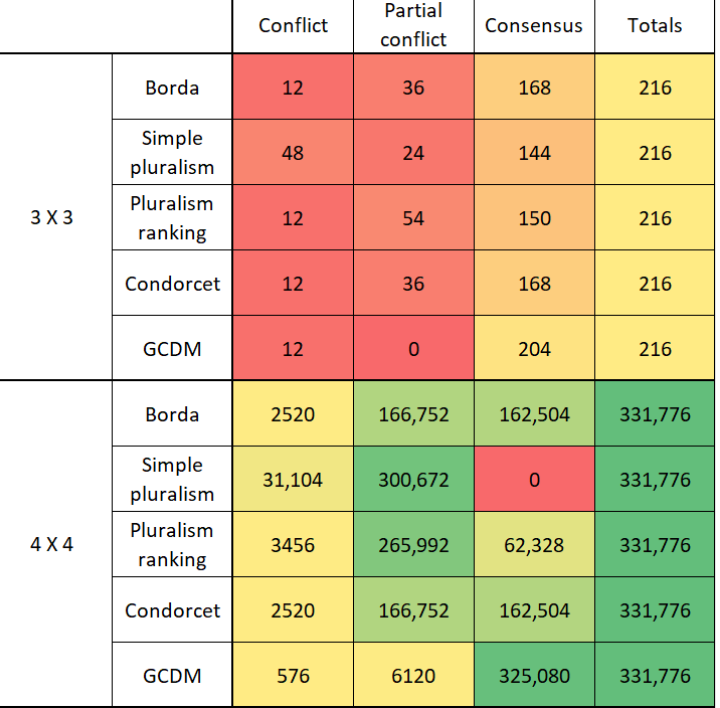
Figure 21. Comparison among voting procedures for 3 × 3 and 4 × 4 matrices. In Figures 23 and 24, we can observe how the GCDM ranking method transforms the conflicts, partial conflicts, and consensus generated by the Borda method. It is noteworthy that the GCDM helps to mark off important preference profile patterns such as unanimities, Latin squares, and ties between